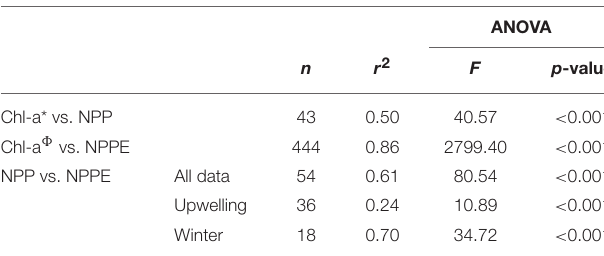
TABLE 3 | Summary of error statistics, i.e., number of observations (n), r 2 coefficient, and ANOVA F and p -values for biological variables